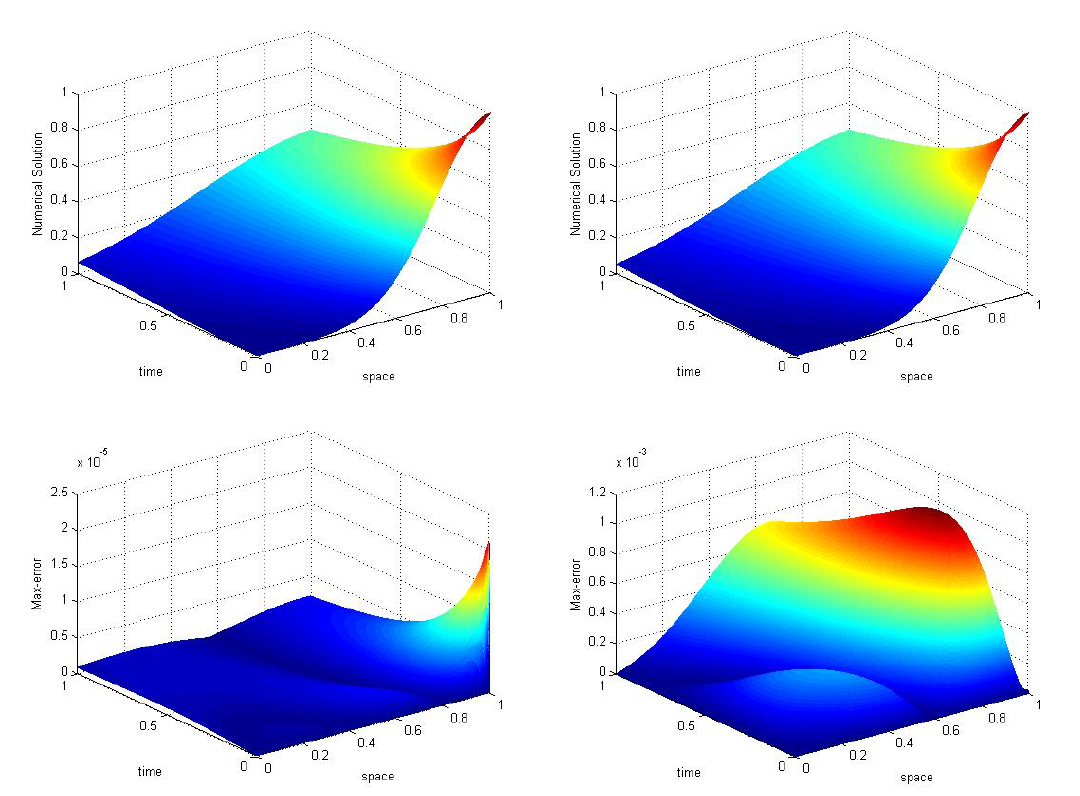
Figure 6. Numerical solution and max-error of modified FVM ( left ) and existing upwind FVM ( right ) for diffusion dominant phenomenon taking ( ∆ t = 1/15,000, ∆ x = 1/320 v = 0.05, k = 0.1 for numerical example